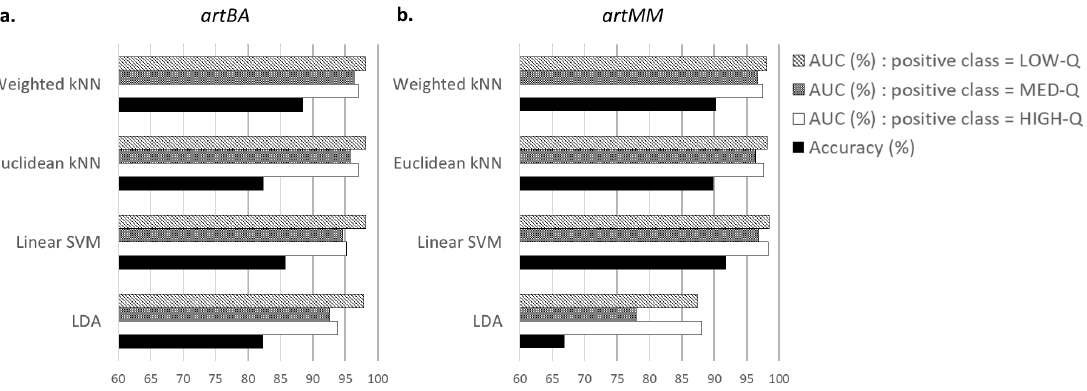
Figure 2. Comparison of classifiers in terms of total accuracy and AUCs (in percentage) of a 5-fold cross validation after features selection on the recordings obtained with ( a ) the standard EEG system ( artBA ) and ( b ) with the dry sensors device ( artMM ). Results are averaged across 5 independent